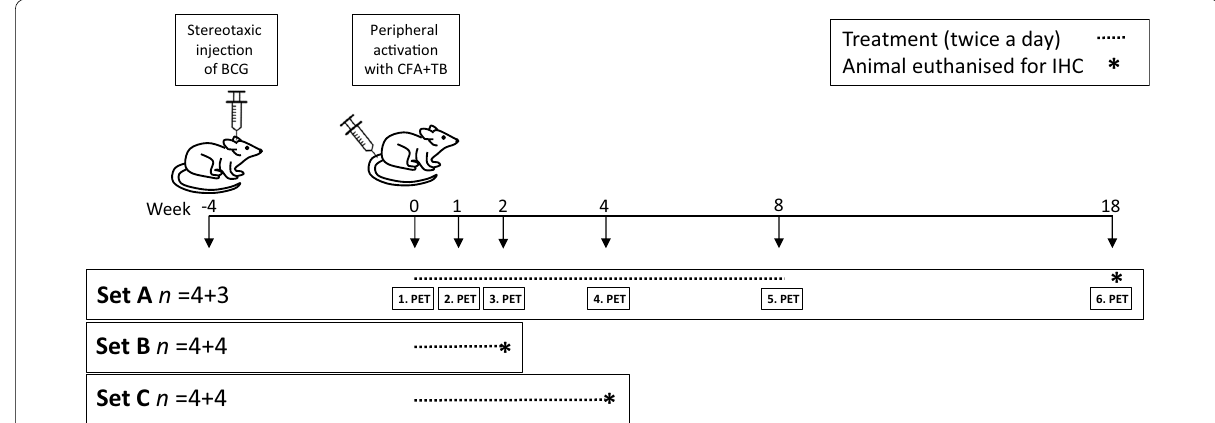
Fig. 1 Study timeline. All animals ( n 24) were operated in week—4 and heat‑killed bacillus Calmette–Guérin (BCG, 10 5 organisms in 2 μL of = phosphate‑buffered saline) was injected stereotaxically in the right striatum over 10 min. At week 0, the animals were intradermally injected with heat‑killed mycobacterium tuberculosis (TB; 1,5 mg) in complete Freund’s adjuvant (CFA) to activate the brain lesion peripherally. Dosing of dimethyl fumarate (DMF; 15 mg/kg) or vehicle (tap water with 0.08% Methocel) using oral gavage was started on day 0 in week 0. Set A animals had a baseline PET study on the same day. Set A animals were imaged during the treatment regimen in weeks 1, 2, 4, and 8, as well as 10 weeks after the treatment finished (i.e. week 18). One Set A animal from the control group died after imaging in week 4. Set B animals were euthanised for